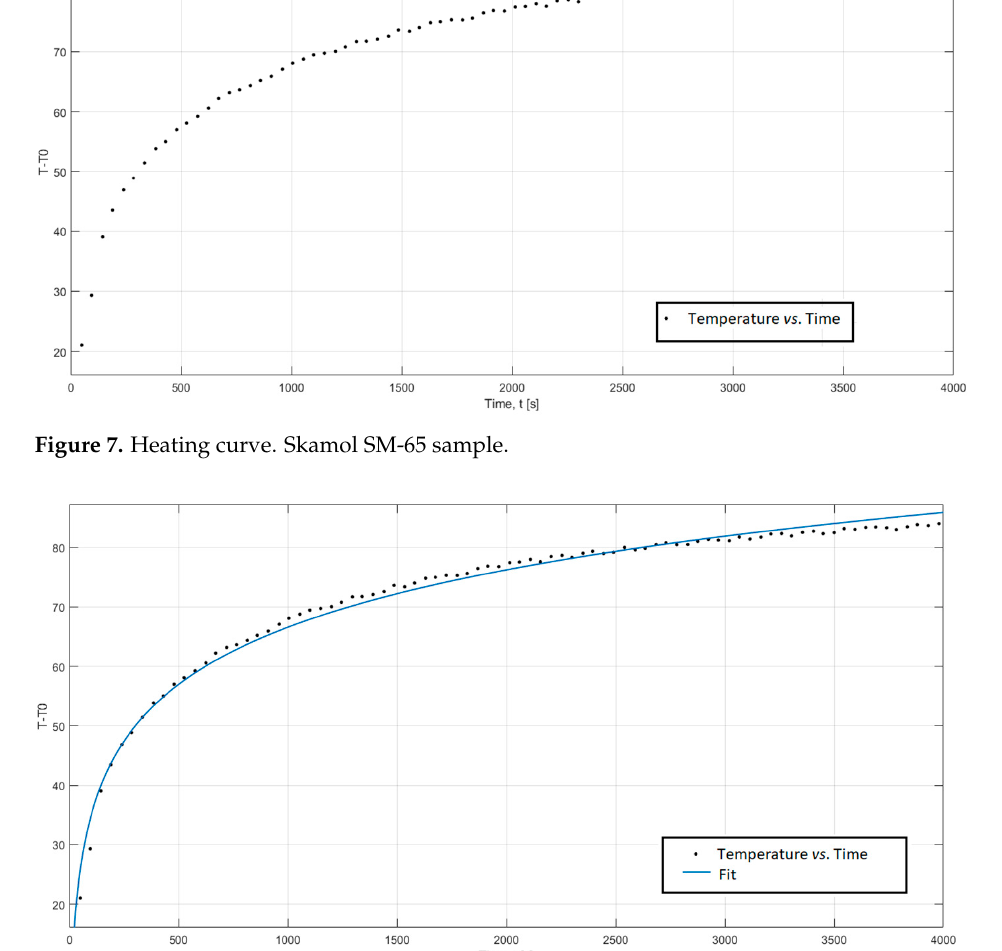
Figure 8. Fit for the Skamol SM-65 sample.